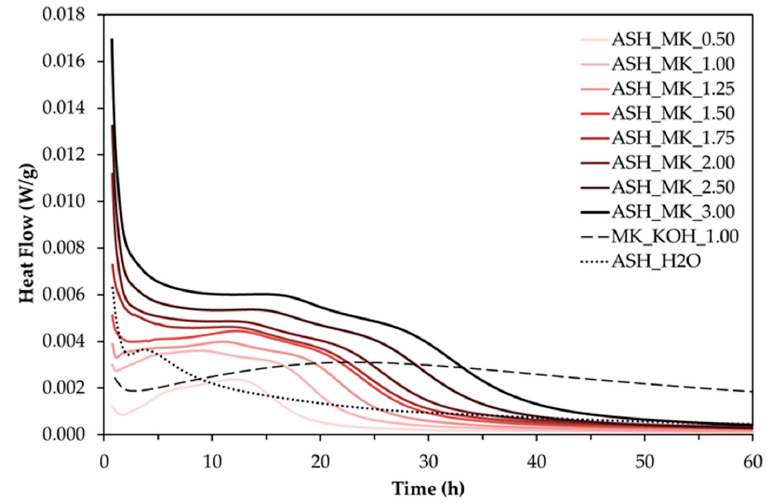
Figure 5. Heat flow development of pastes up to 60 h at T = 25 °C.